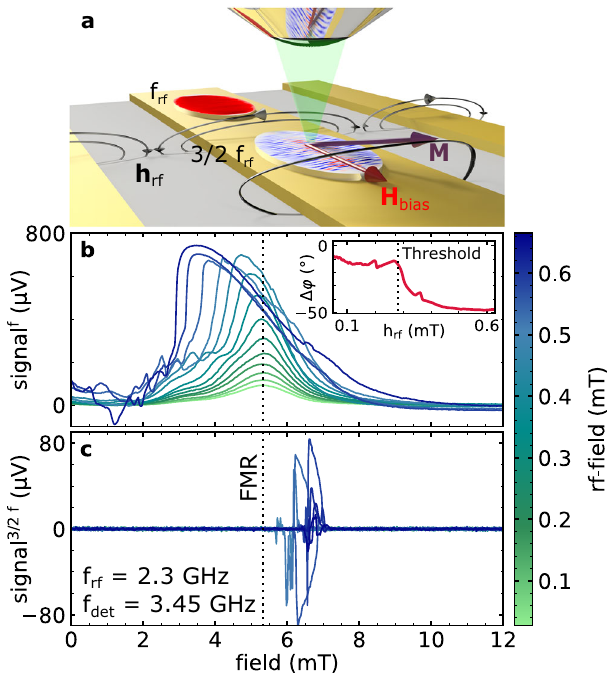
Fig. 1 | Experimental geometry and fi eldswept SNS-MOKE measurements at f rf and 3/2 f rf . In a , the experimental geometry is depicted. In b and c , fi eld swept measurementswithanexcitationat2.3GHzwereperformedasafunctionoftherf- fi eldamplitudeindicatedbythecolorcode.In b ,theimaginarypartofthedynamic susceptibility detected at f rf shows a typical Lorentzian line shape for low power levelswiththeresonance fi eldindicatedbytheblackdottedline.Thephaseshiftas afunctionofrf- fi eldamplitudeisshownintheinsetof b .In c ,theNLSWresponseat 3/2 f rf is